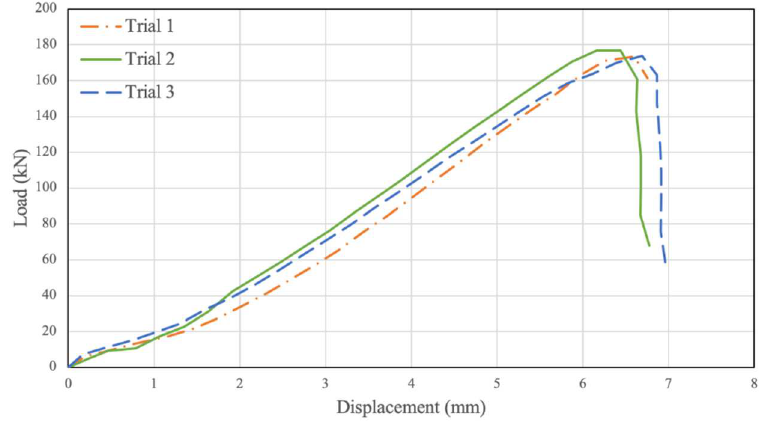
Figure 9. Confined 4.5 Mpa. Displacement vs. Load.